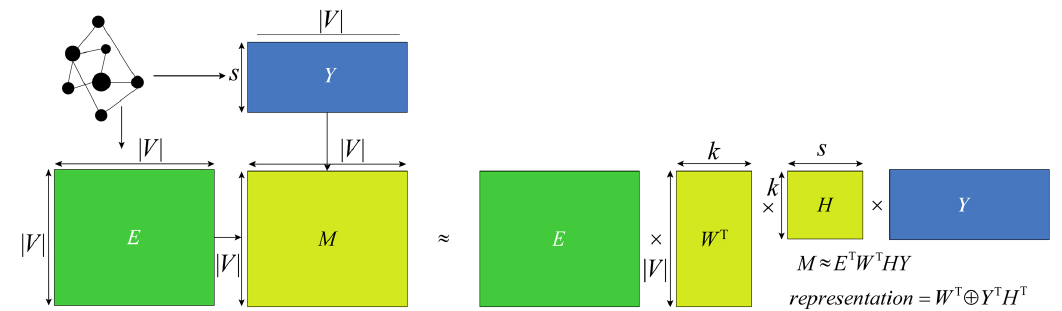
Fig. 3 Framework of modeling network vertex relations by TFNR